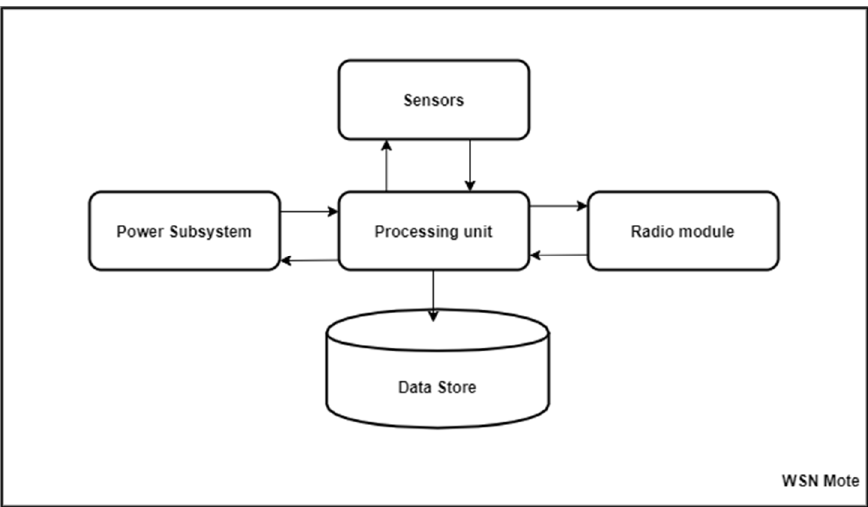
Figure 1. Schematic of the four subsystems of each